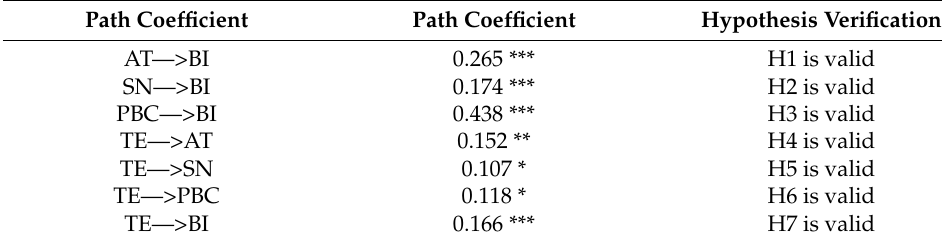
Table 6. Path coefficients and hypothesis verification.